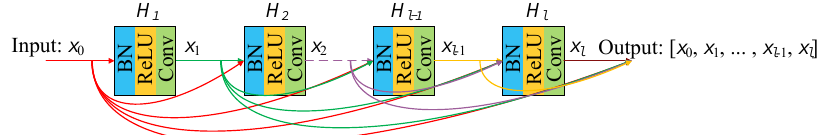
Figure 3. Architecture of a dense block. BN, batch normalization.